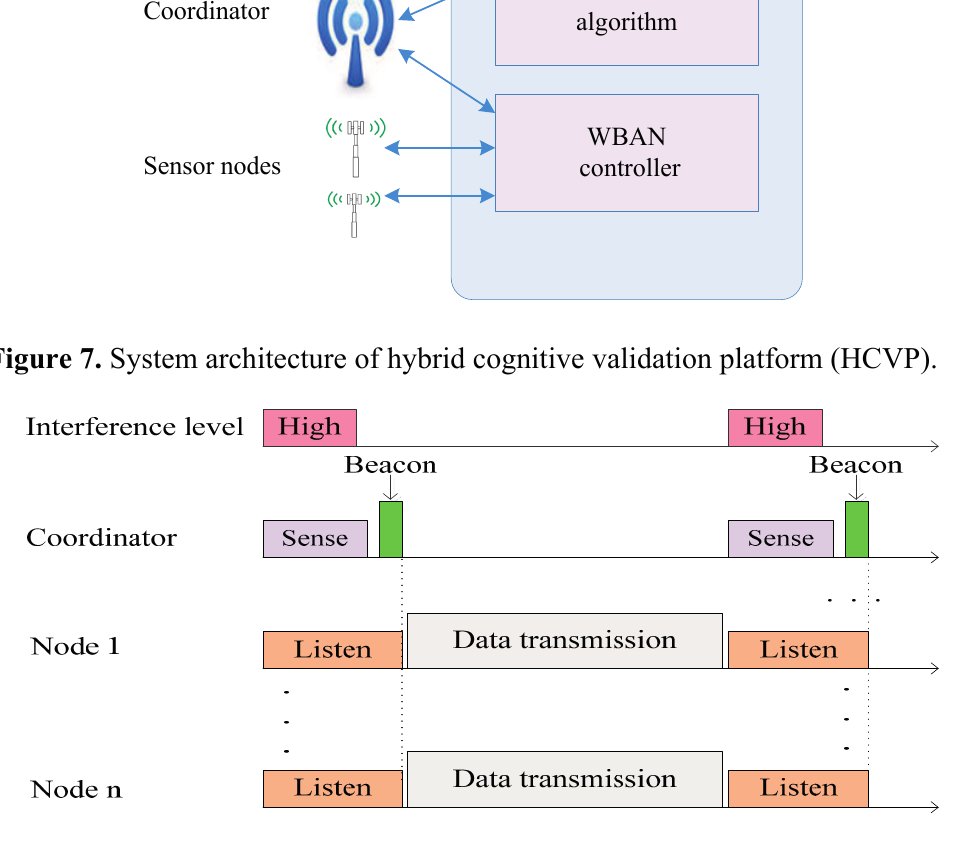
Figure 8. Adaptive CR-MAC